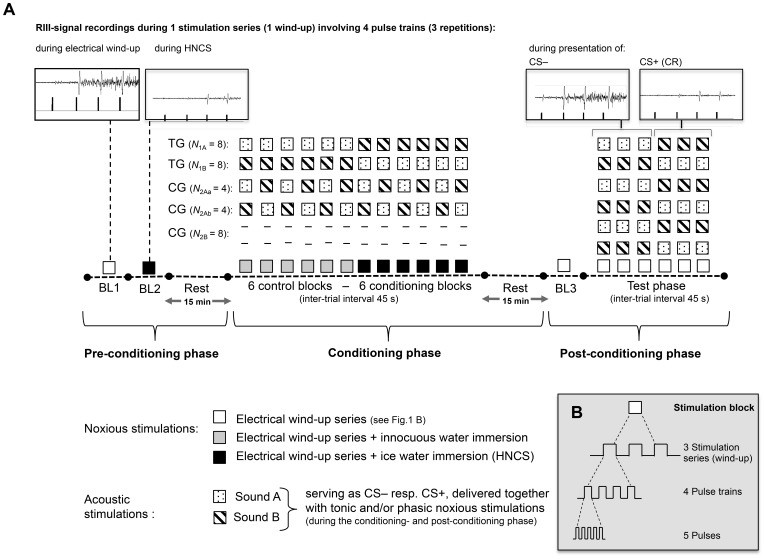
Experimental protocol.Abbreviations: HNCS = heterotopic noxious counter-stimulation, UCR = unconditioned response, CS = conditioned stimulus, CS– = unpaired conditioned stimulus, CS+ = paired conditioned stimulus, CR = conditioned response, TG = test group (N1 = 16), CG = control group (N2 = 16), BL = baseline. (A) Stimulus presentations during the pre-conditioning, conditioning and post-conditioning phases (see further details in the text. (B) Electrical stimulation sequences delivered over each stimulation block.